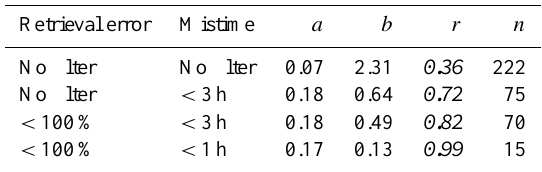
Table 3. Statistical analysis of the CalNex and IASI satellite vmr comparison. The slope ( a ) and the intercept ( b ) of the linear regres- sions are indicated for various criteria on the data selection, as well as their respective Pearson’s correlation coefficients ( r , in italic font when significant); n correspond to the number of pairs of observa-